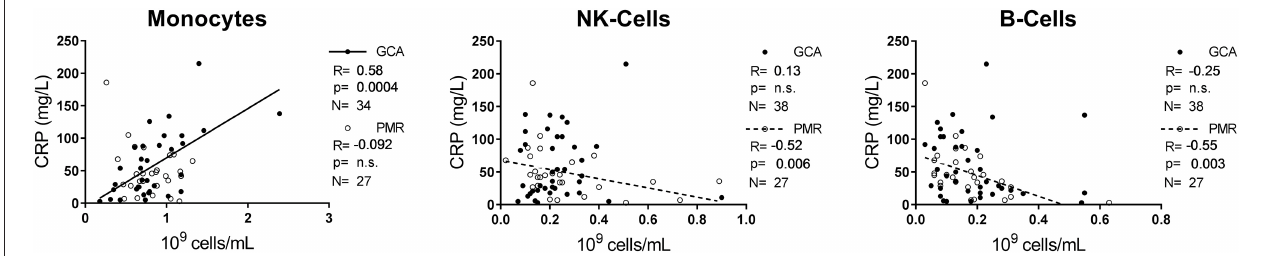
FIGURE 2 | Correlations between three leukocyte subsets and the inflammatory marker CRP. Correlations between CRP and the leukocyte subset in pre-treatment GCA (closed circles) and PMR (open circles) patients. Spearman’s R , the p -value of the correlation and the N are indicated in each graph for GCA and PMR. Regression line for GCA is shown as an uninterrupted line, for PMR as a dotted line. Correlations for neutrophils, CD4 + T-cells, and CD8 + T-cells are displayed in Supplementary Figure 2 .